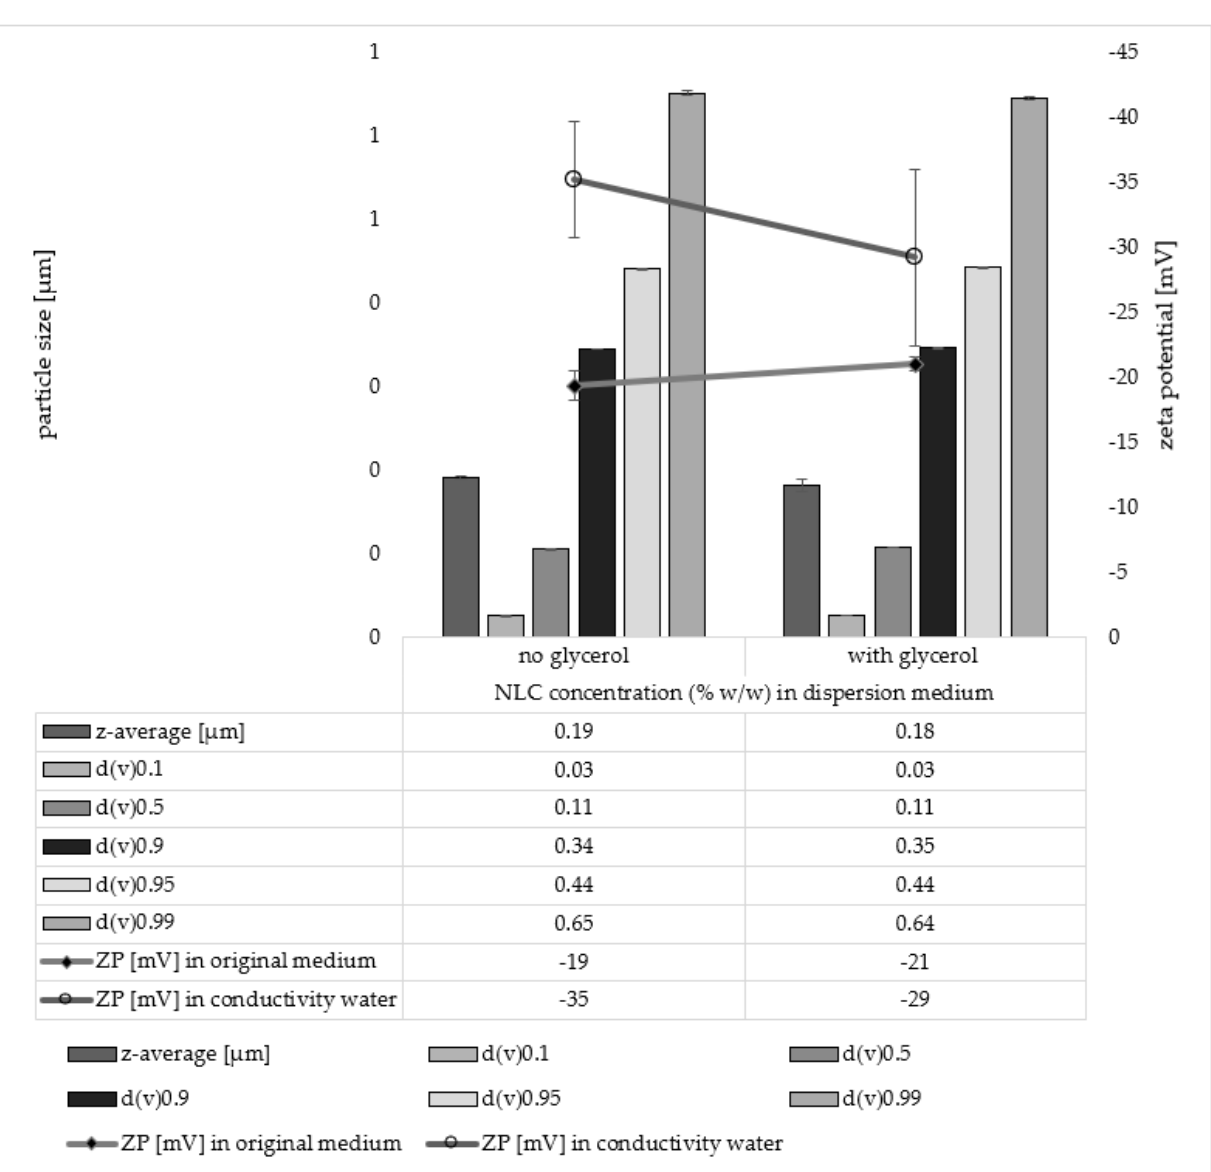
Figure 7. Influence of glycerol on particle size and zeta potential of the NLC dispersion. The particle size was assessed with dynamic light scattering which yields the hydrodynamic diameter (z-average). Laser diffraction was used to determine the volume-based size distribution of the particle dispersions. The obtained median volumetric diameters d(v)0.1–d(v)0.99 ( µ m) represent the percentage of the volume of the particles within the dispersion that are equal or below the given size. Zeta potentials (mV) were analysed in the original medium and in conductivity water, respectively.